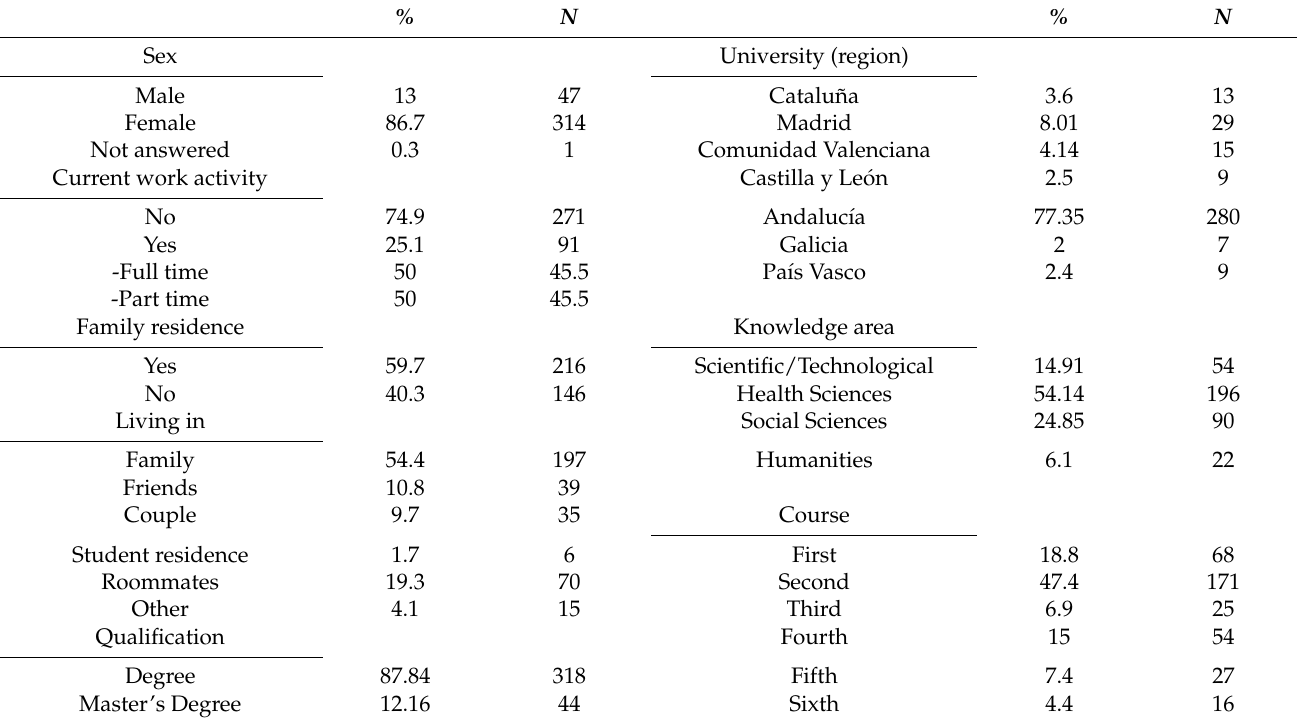
Table 1. Percentages of the total sample according to sex, current work activity, housing, cohabitation, university, degree, area of knowledge, and